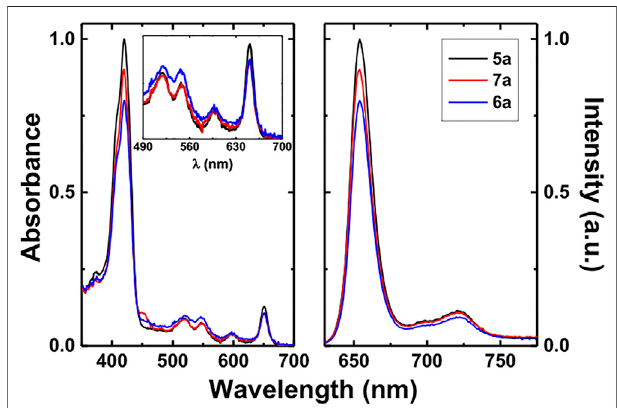
FIGURE 1 | Normalize room temperature absorption (left) and fl uorescence emission (right) spectra of chlorins 4a , 5a , 6a , and 7a in DMSO solution ( λ exc = 425